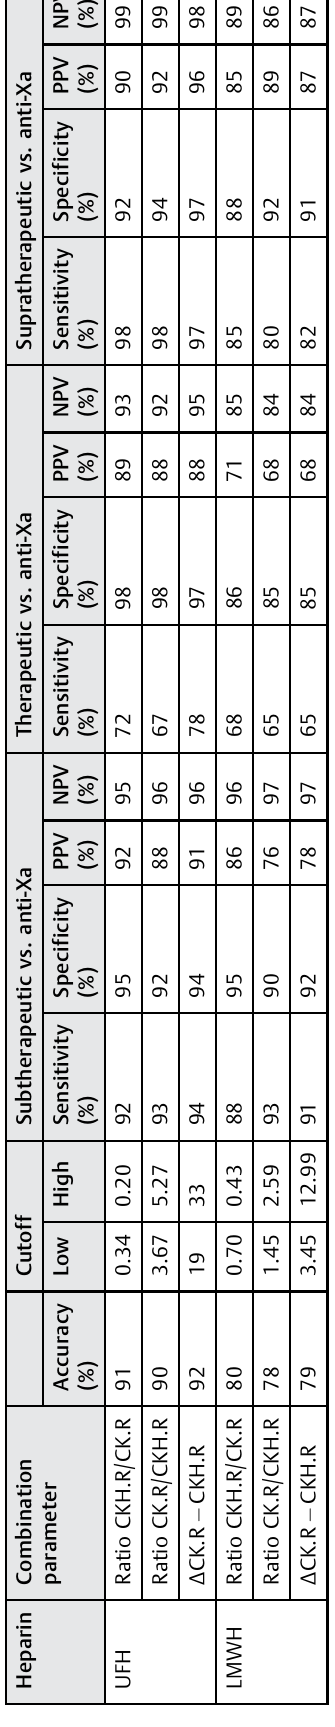
( ► Supplementary Fig. 1B ) concentration (UFH, slope β ¼ (cid:3) 3.16, p < 0.001; LMWH, slope β ¼(cid:3) 1.31, p < 0.001).